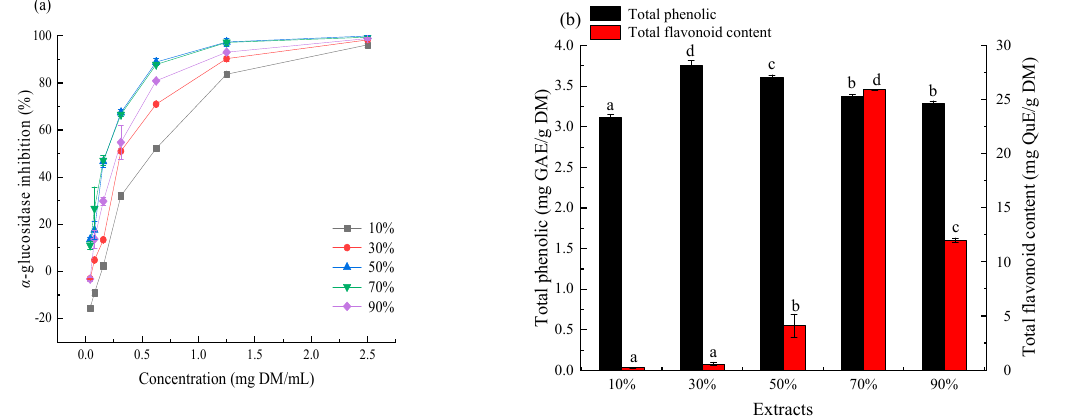
Figure 1. α -Glucosidase inhibition ( a ), total phenolic and total flavonoid content ( b ), of Ceratophyllum demersum L. (CDL) extracts prepared with different concentrations of methanol aqueous solvent.